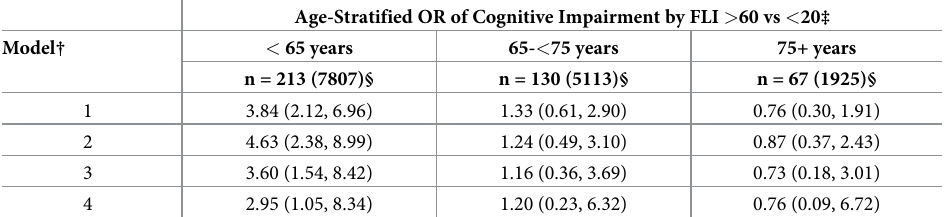
Table 3. Odds ratio (95% confidence interval) of cognitive impairment by